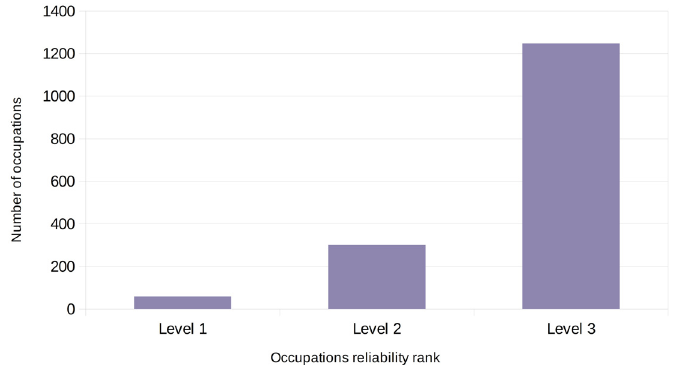
Figure 2: Classi fi cation of 1,606 occupations dated between 9500 and 5500 cal. BCE in the western Mediterranean according to their reliability: level 1 good, level 2 medium, and level 3